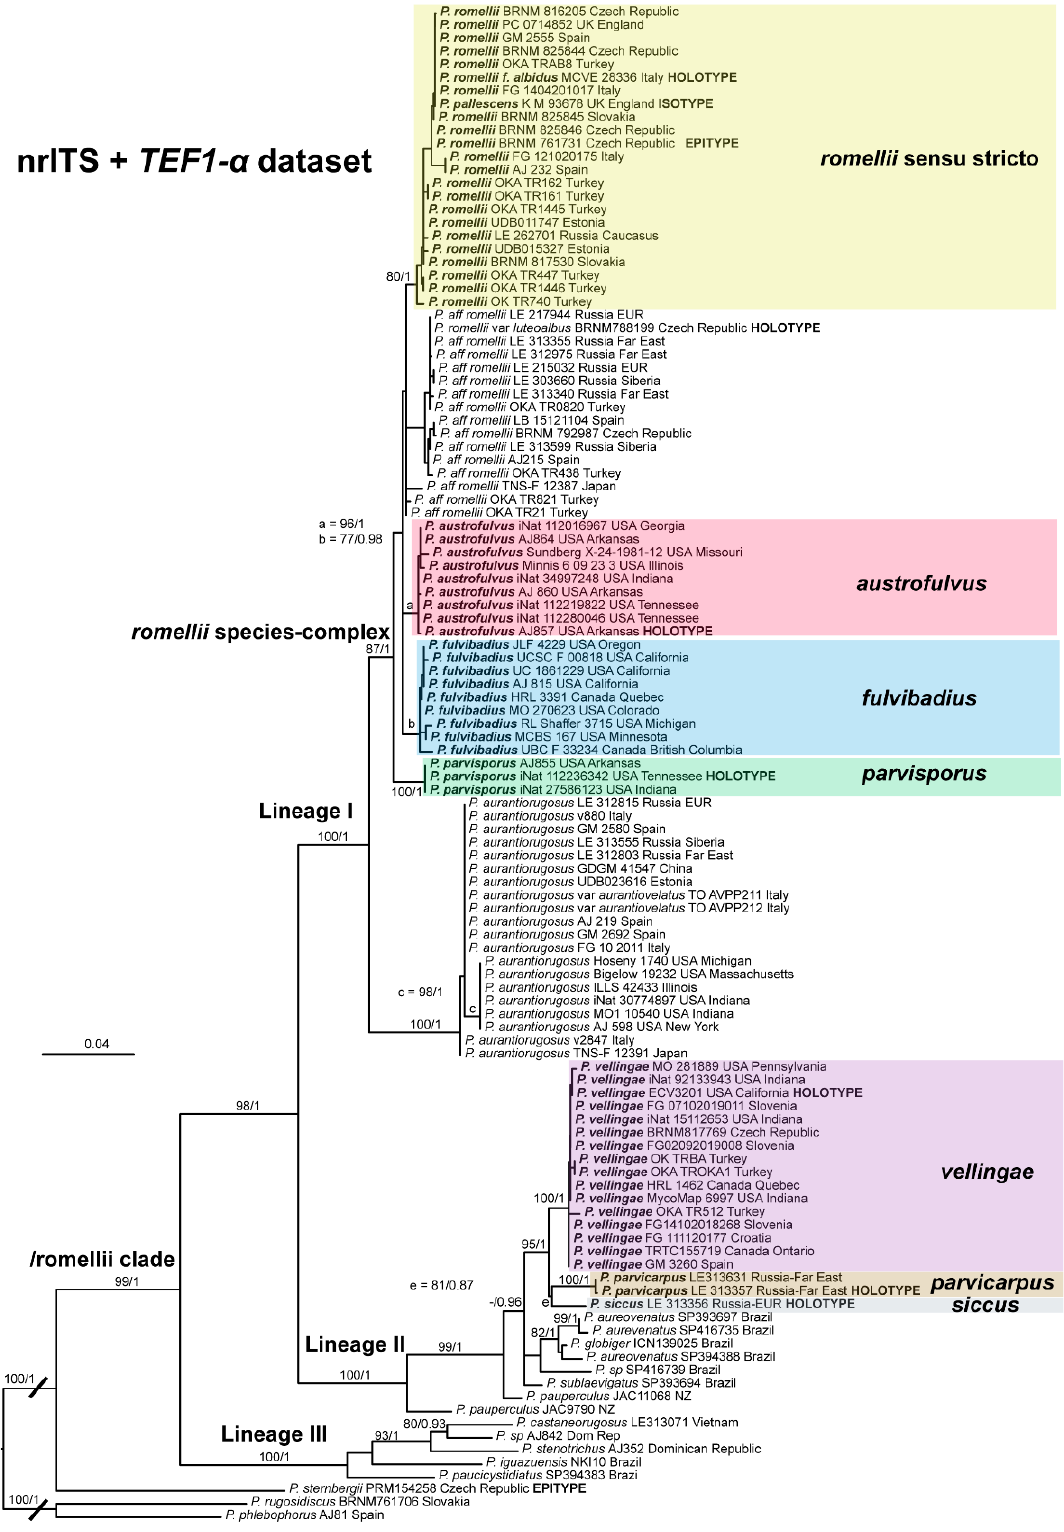
Figure 1. Best tree from the ML analysis of the nrITS + TEF1- α dataset. BS values ( ≥ 70%) and PP values ( ≥ 0.90) are shown on or below the branches. Root length has been reduced to accommodate graphical representation. Scale bar indicates the mean number of nucleotide substitutions per site.